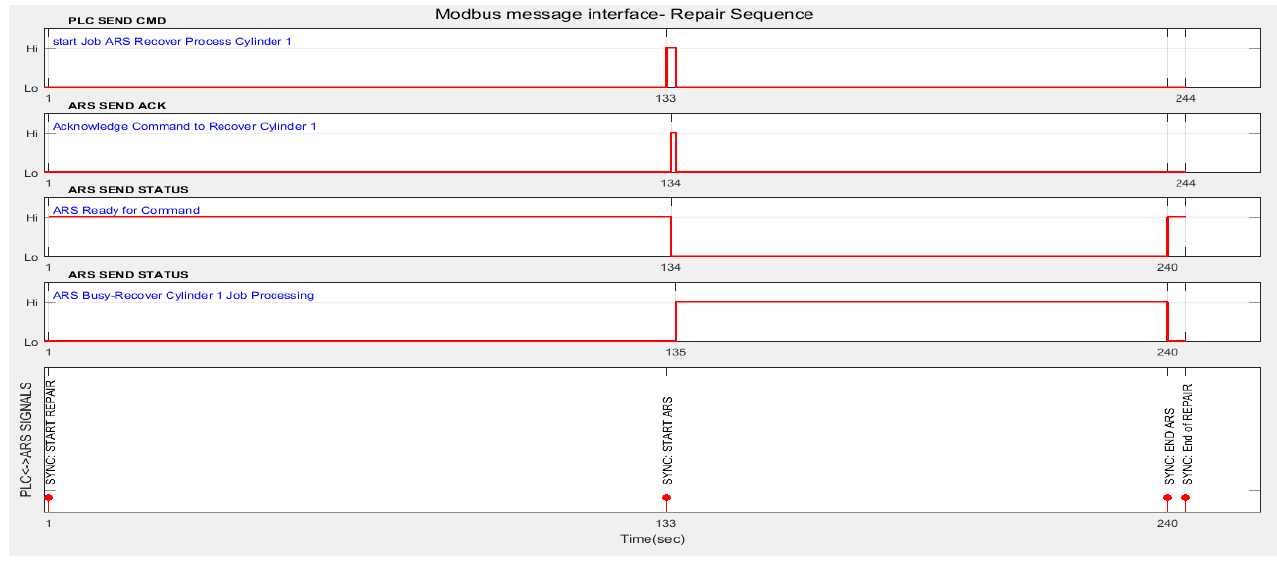
Figure 24. Handshake sequence interfacing master PLC S7 1200 and ARS.